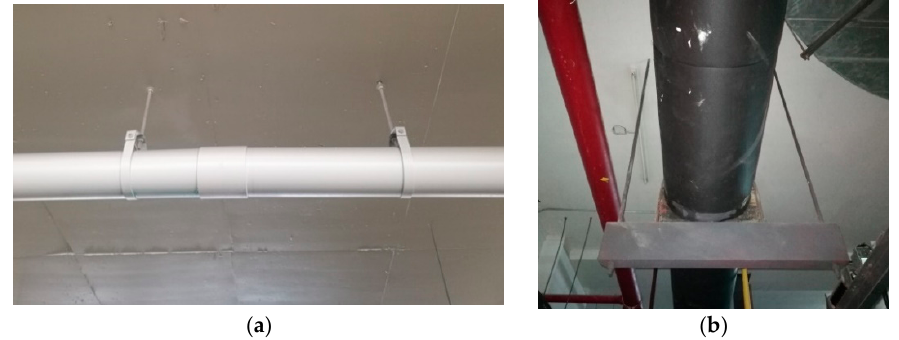
Figure 1. Two types of suspended piping systems: ( a ) A single rod piping system; ( b ) trapeze hangers supporting a suspended piping system.